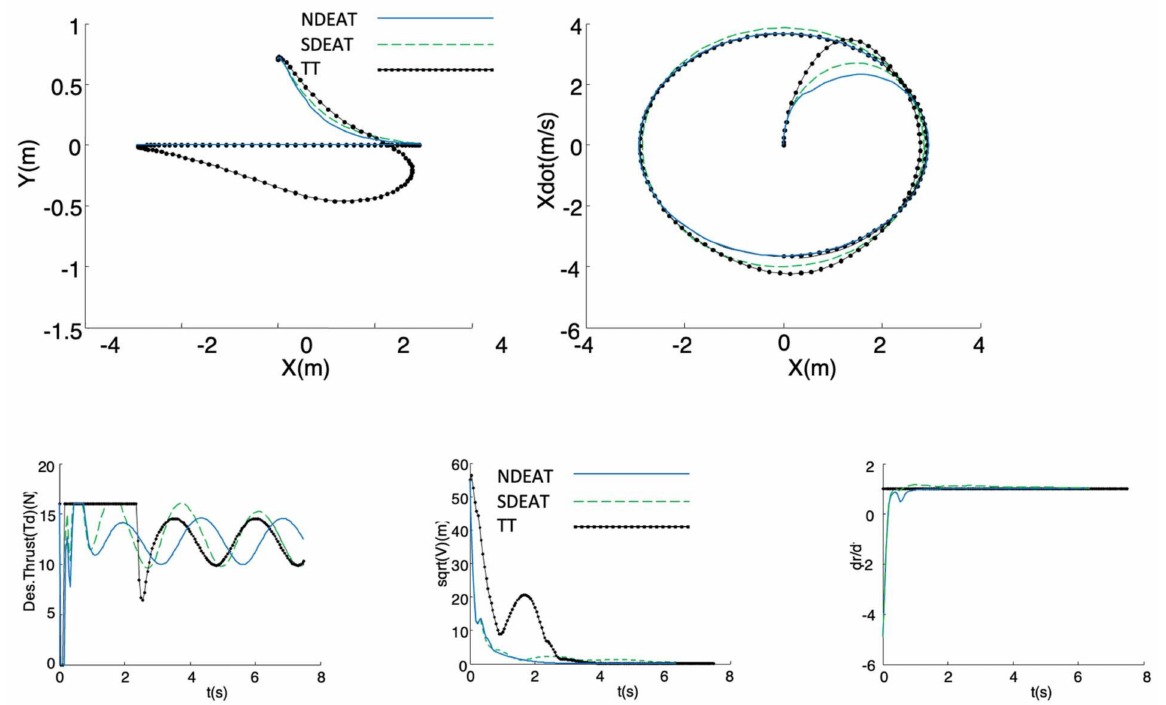
Figure 6. Comparison of NDEAT, SDEAT and TT when the robot is neither delayed nor ahead. Up : Left , Y/X trajectories (same desired path as previous Figure 4); Right : evolution of Left , Desired Thrust Td (with saturation). Middle : Lyapunov function versus time. Right : evolution of σ = dr / dt with respect to